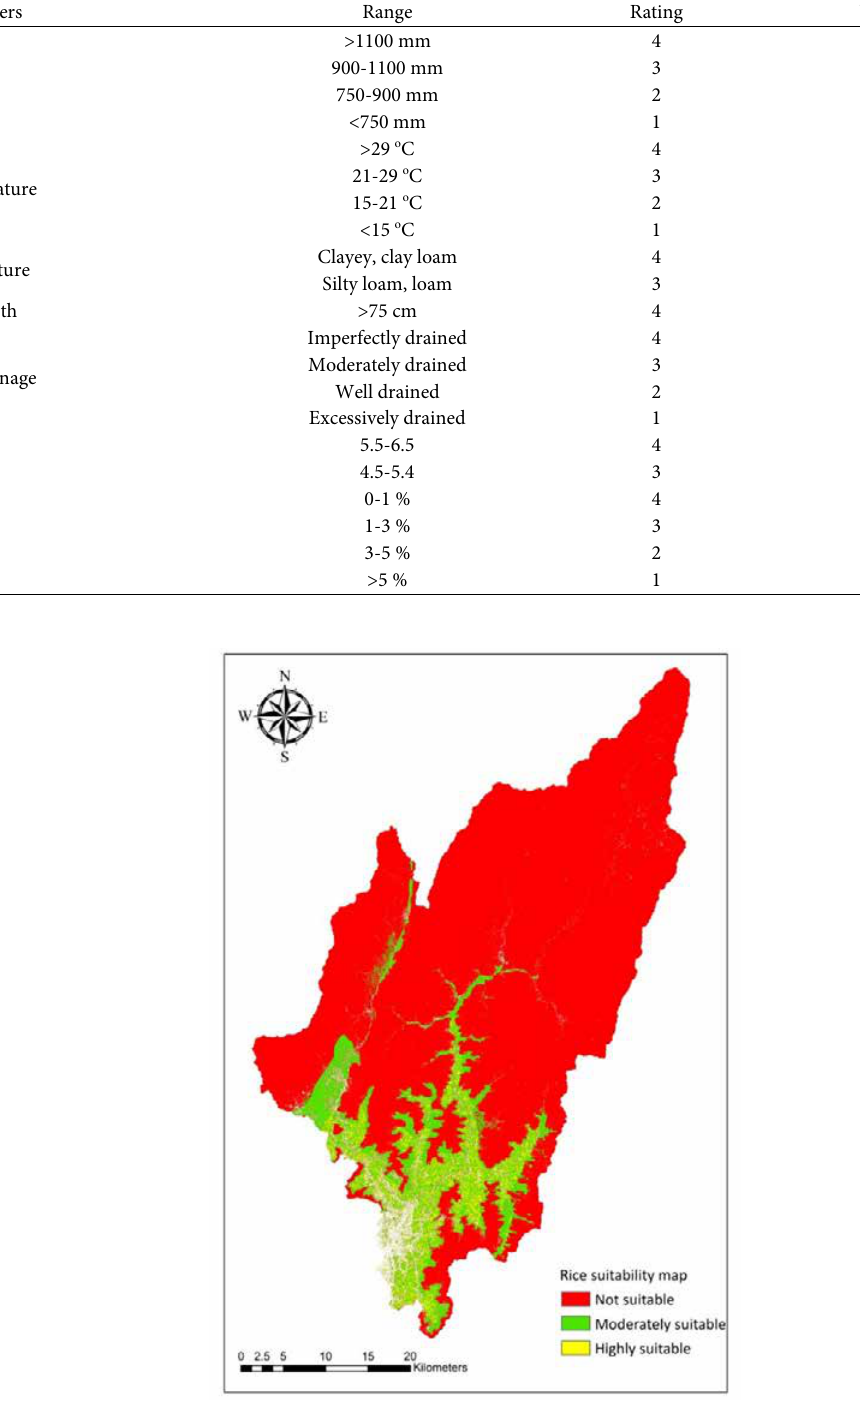
Fig. 4: Suitability map for rice Fig.4: Suitability map for rice crop